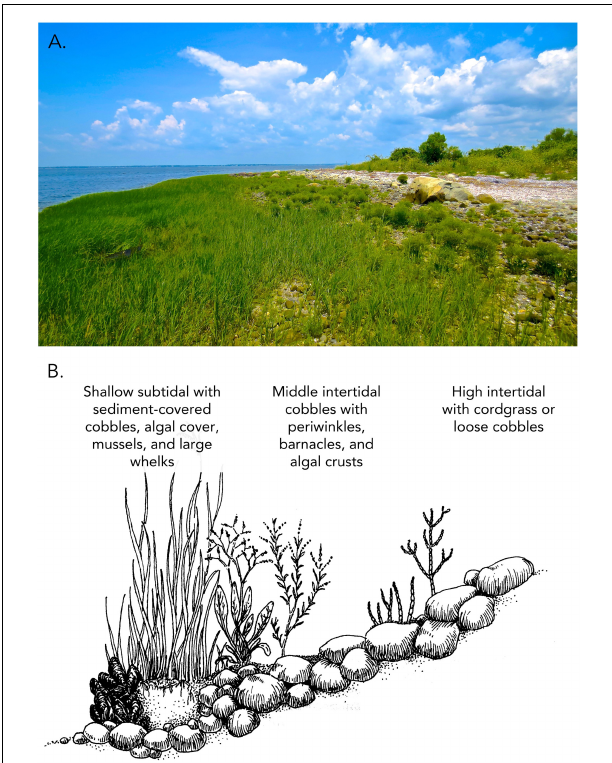
FIGURE 1 | Cobble beach plant communities. Biodiversity and community biomass are dependent on substrate stabilization and buffering of wave stress by cordgrass both within stands of cordgrass and within wave-protected areas behind cordgrass beds of threshold sizes (A) . Common cobble beach plants occur behind beds of all sizes, while rare cobble beach plants are only found in the largest beds, shown in (B) (adapted from Bertness,